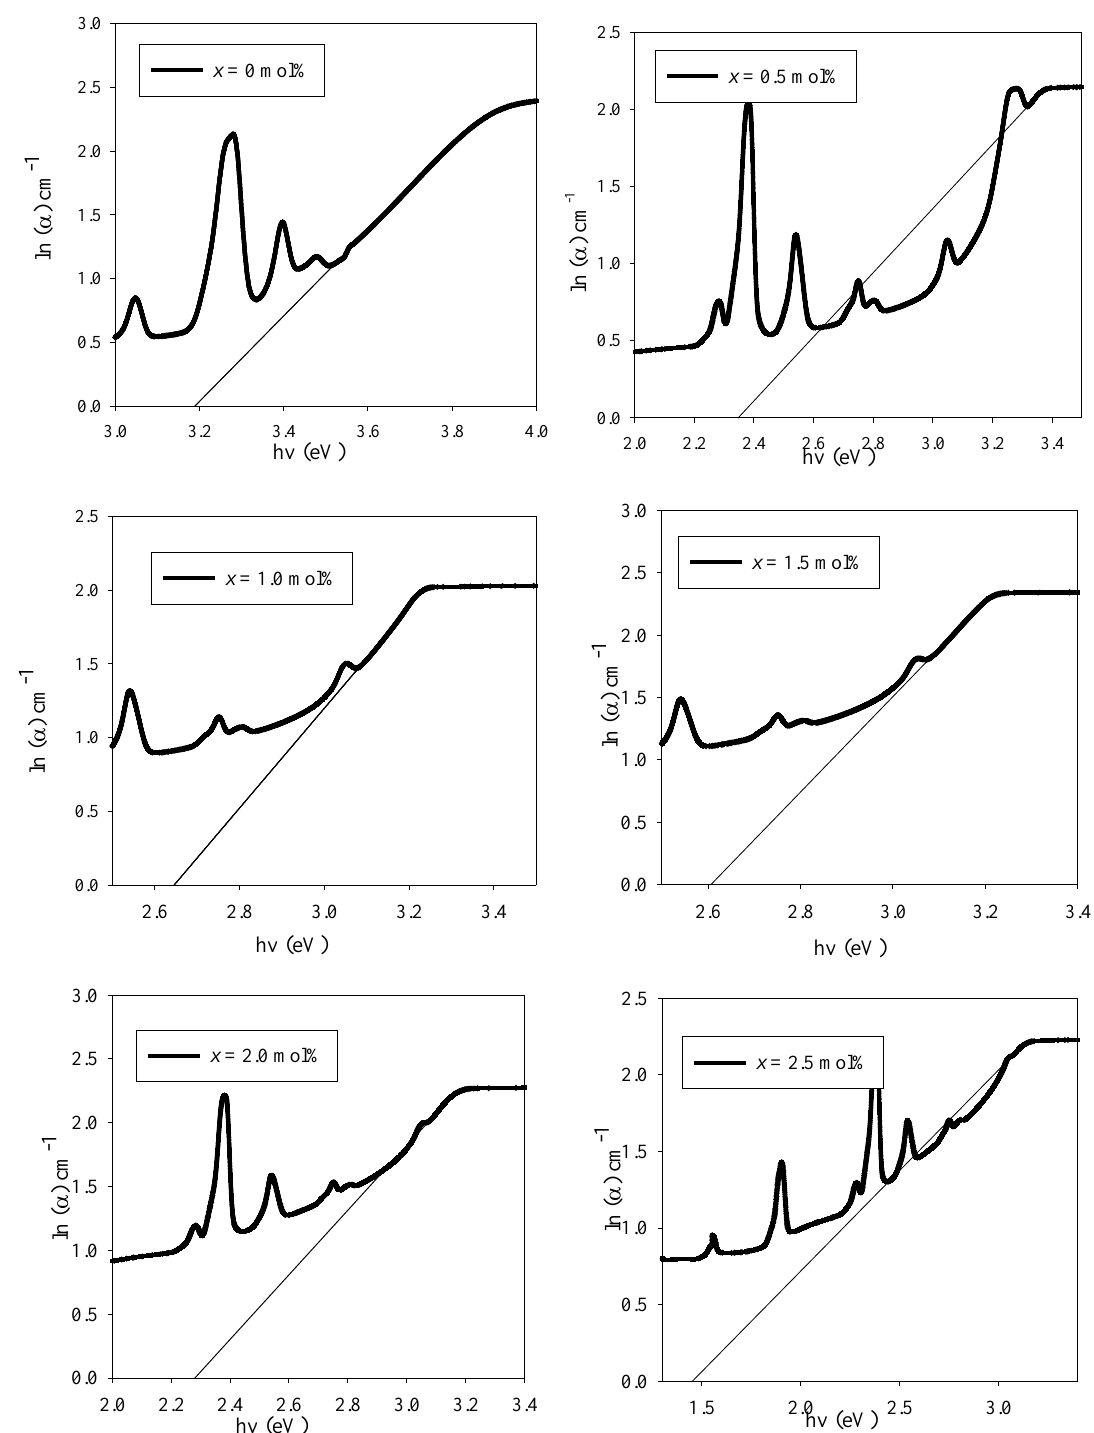
Figure 7. The graph of ln ( α ) against photon energy, hv (eV) of (59.5– x ) B 2 O 3 –20Na 2 O–20CaO– x V 2 O 5 –Er 2 O 3 –0.5AgCl ( x = 0, 0.5, 1.0, 1.5, 2.0 and 2.5 mol%). The graphs showed the determination of the Urbach energy for the glass samples.